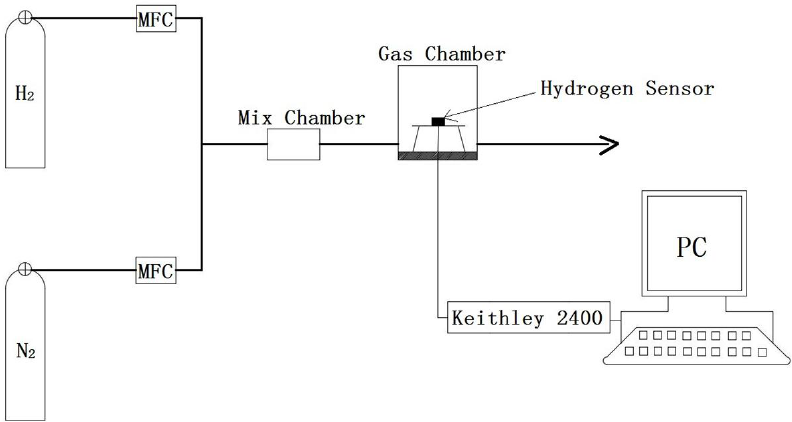
Figure 3. Schematic of the hydrogen measuring system.